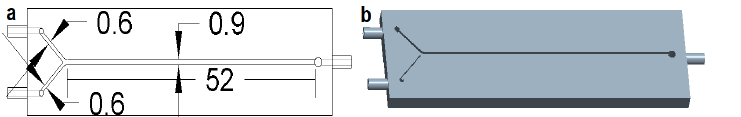
Figure 1. CAD illustrations of the micromixer design. ( a ) CAD drawing of the designed micromixer with dimensions in mm; ( b ) 3D CAD model of the micromixer.